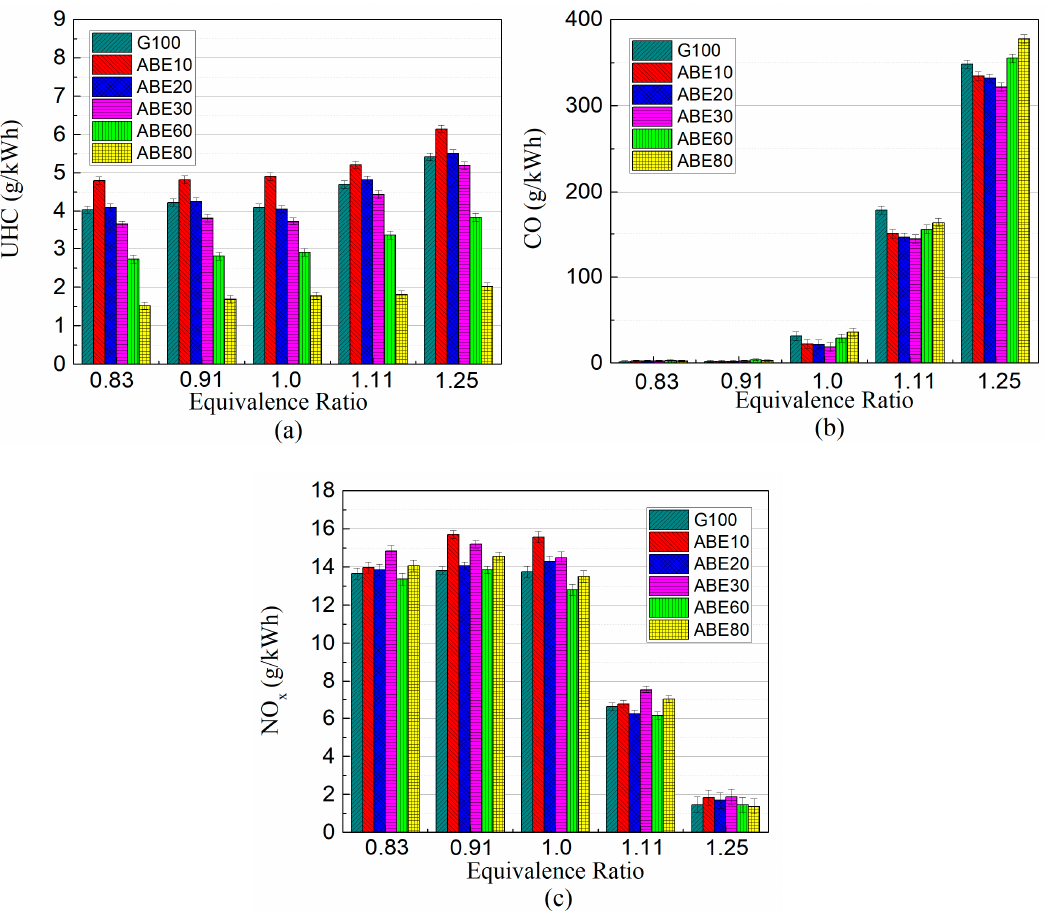
Figure 2. Regulated emissions of ( a ) UHC, ( b ) CO and ( c ) NO x at 3 bar BMEP under different equivalence ratios.